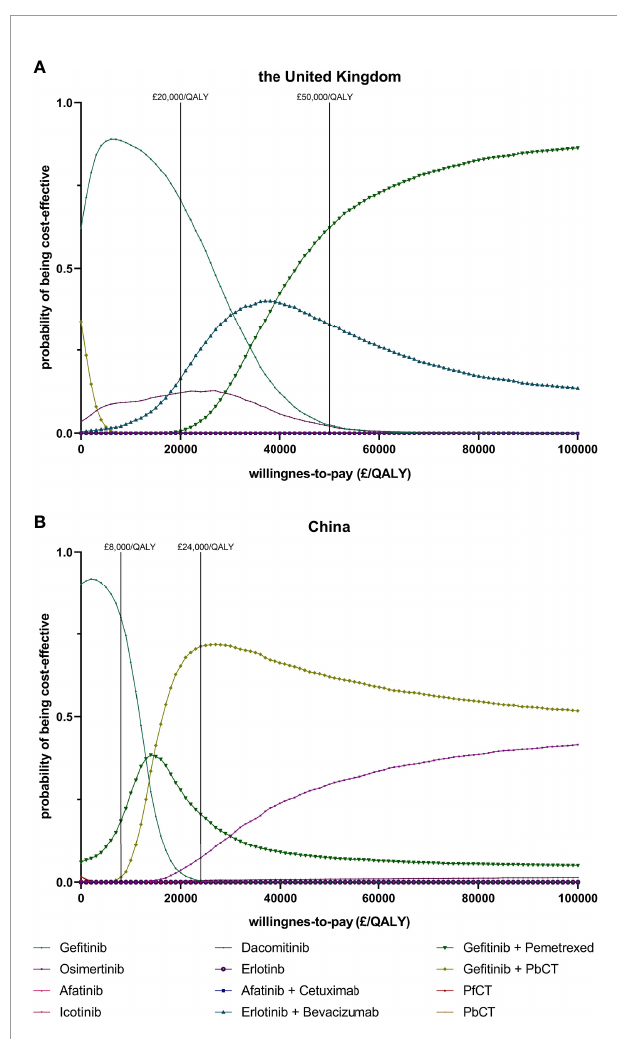
FIGURE 2 | Cost effectiveness acceptability curves indicating the probability of each fi rst-line treatment to be cost-effective at different willingness to pay thresholds in the UK (A) and the Chinese setting (B) . (PfCT, pemetrexed free chemotherapy; PbCT, pemetrexed based chemotherapy; QALY, quality- adjusted life